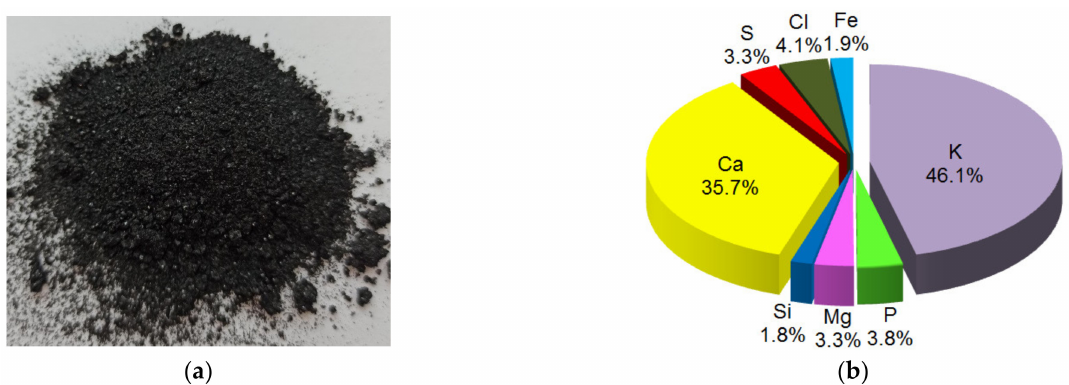
Figure 3. Biochar: ( a ) photography; ( b ) elemental composition of mineral